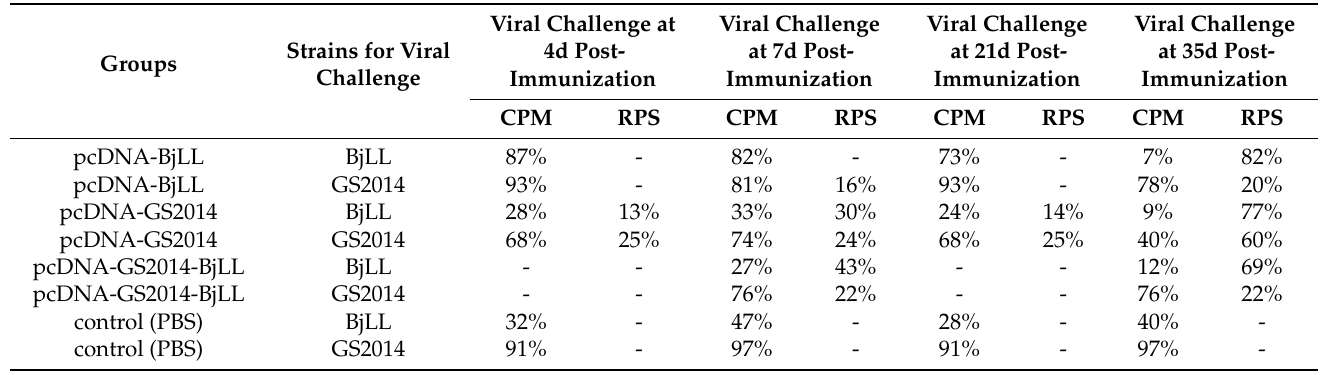
Table 1. Mortality of the immunity protective